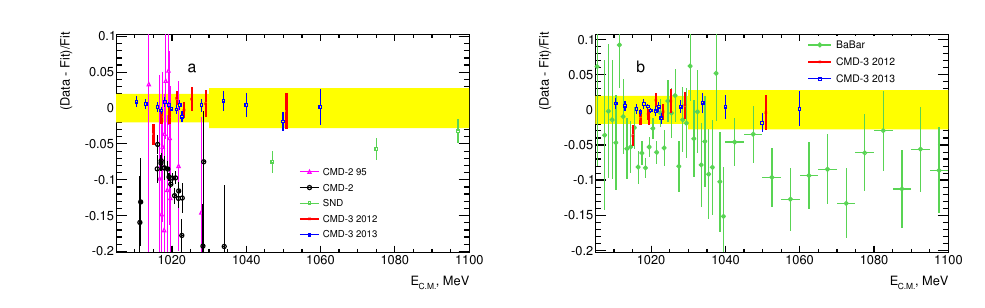
Figure 10. Comparison of the CMD-3 measure- ment of e + e − → K + K − to the BaBar measure- ment [16] using the ISR approach. The width of the band shows the systematic uncertainties in the CMD-3 study.